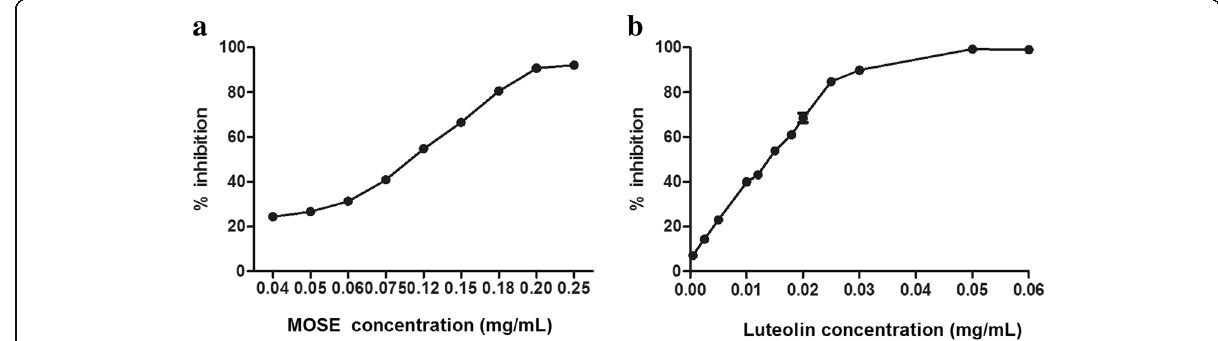
Fig. 1 DPPH radical scavenging assay of MOSE ( a ) and luteolin ( b ). The results are expressed as percentage inhibition of DPPH radical formation. Data are expressed as the mean ± SEM of three separate